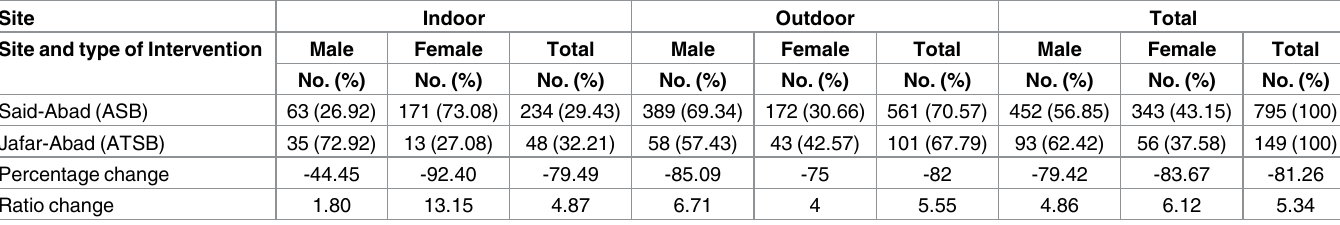
Table 4. The comparison of P . papatasi frequency indoors and outdoors in Jafar-Abadand Said-Abad using light traps (plants, bushes, and shrubs sprayed with ATSB and ASB, Markazi District, Qom province, 2015. Site Indoor Outdoor Total Site and type of Intervention Said-Abad (ASB) Jafar-Abad (ATSB) Percentage